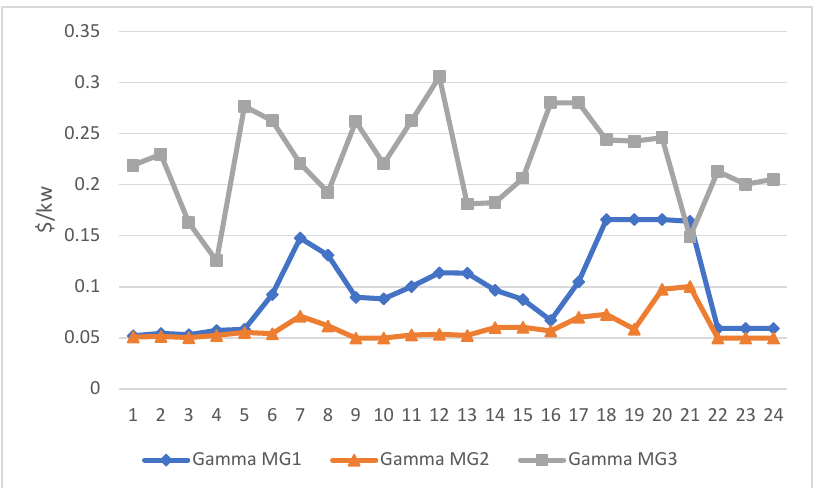
Figure 6. The basic price of buying and selling energy from the grid output by the PSO model in model 1.